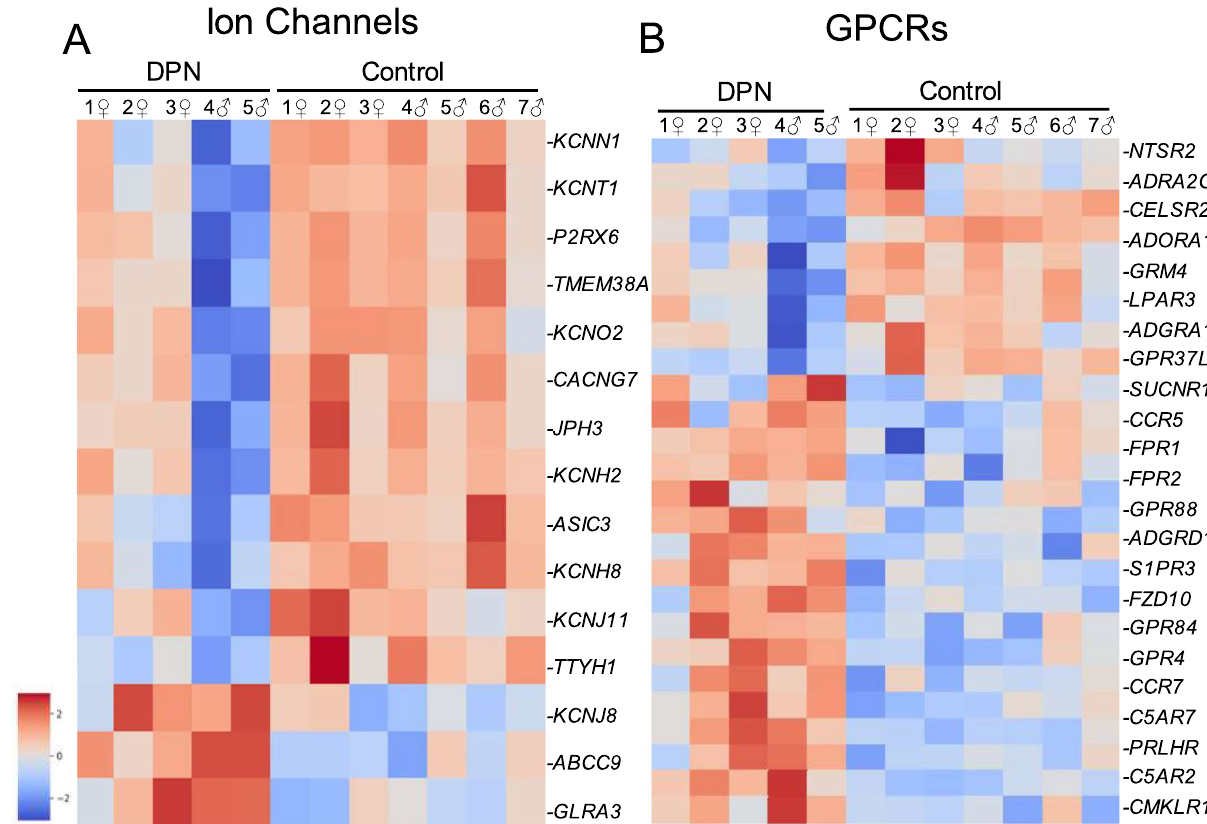
Figure 3. Heatmaps of genes dysregulated in DPN individuals that encode for ( A ) ion channels and ( B ) G protein coupled receptors. Ion channels and GPCR signaling can affect nociceptor firing. Transcription factors can alter the expression of key ion channels and GPCRs that can subsequently promote nociceptor hyperactivity. Kinases can modify the activity of ion channels and GPCRs through post-translational phosphorylation to then regulate the sensitivity to noxious stimuli in